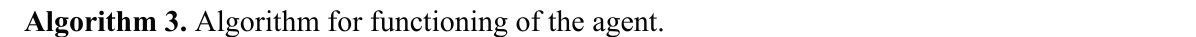
Algorithm 3. Algorithm for functioning of the